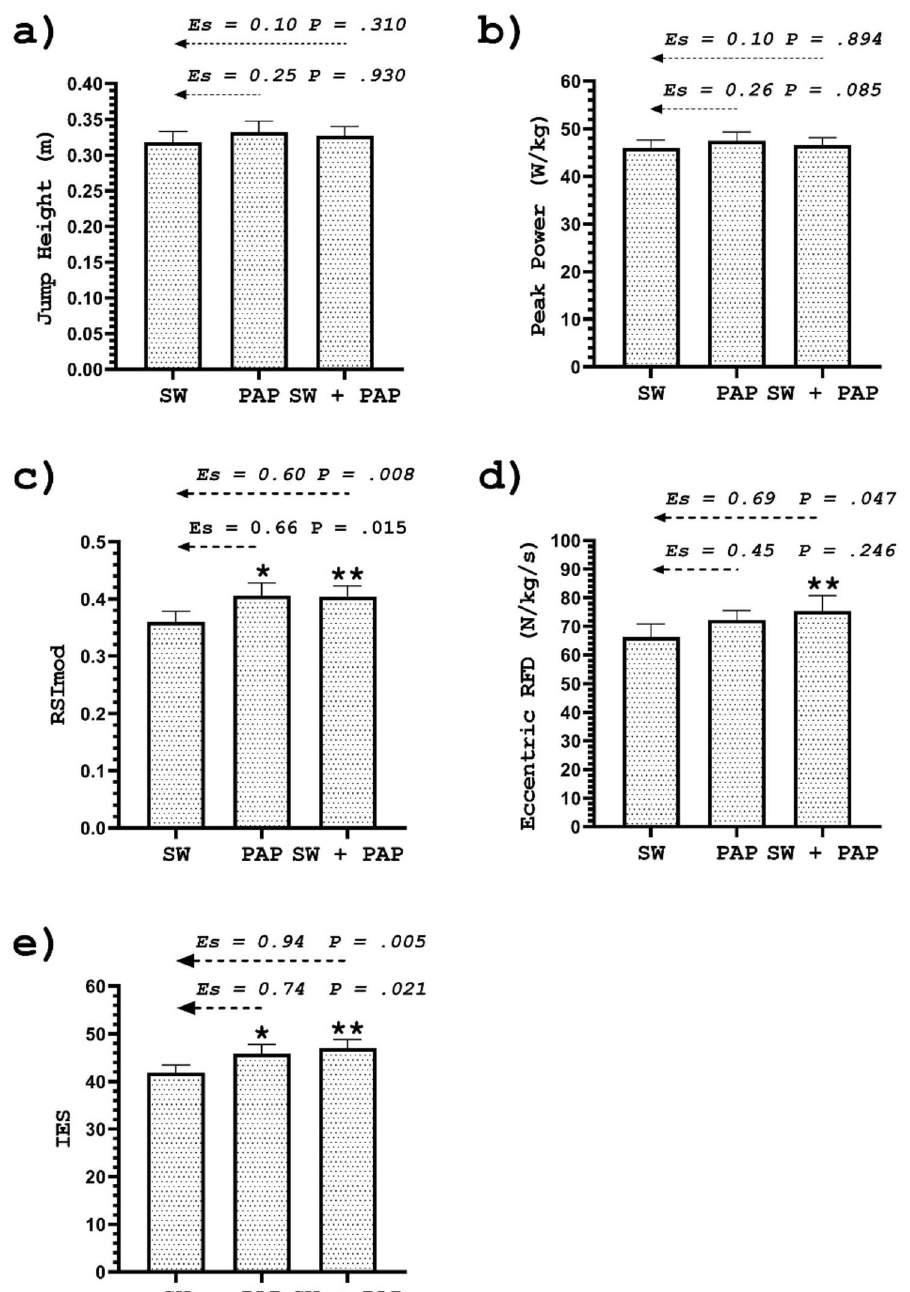
Figure 2. Jump height ( a ), peak power ( b ), RSImod ( c ), eccentric RFD ( d ), IES ( e ) after a swim-specific warm-up (SW), PAPE, and swim-specific warm-up with PAPE (SW + PAPE). *Indicates a significant difference between the SW and PAPE. **Indicates a significant difference between SW and SW + PAPE. ES effect size. P- p-value. The results are plotted as mean ±